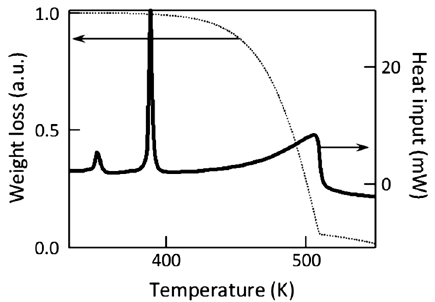
FIG. 7. TGA results for BPT powder. Measurements are realized in